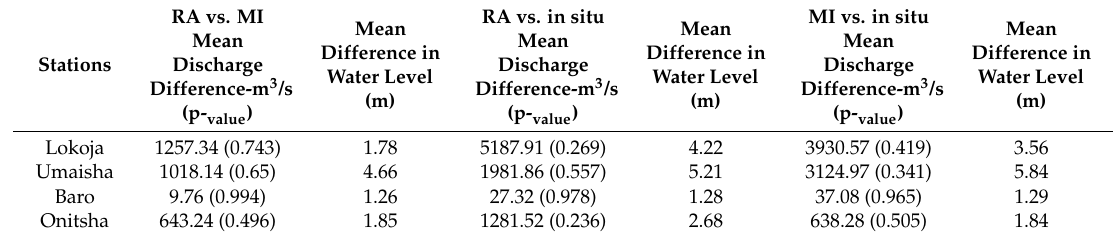
Table 9. Permutation test results including the mean difference in water level between the two techniques. RA vs. MI Mean Stations